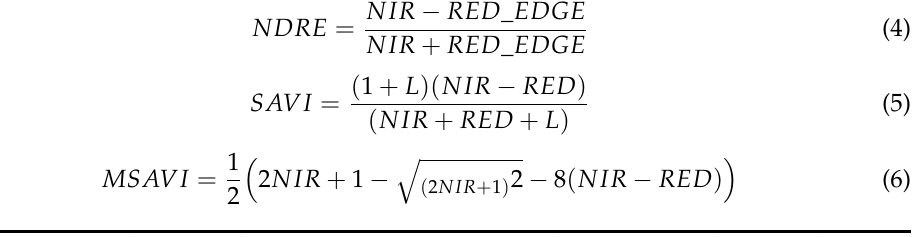
Algorithm 1: Algorithm for estimating vegetative indices with multispectral imagery.